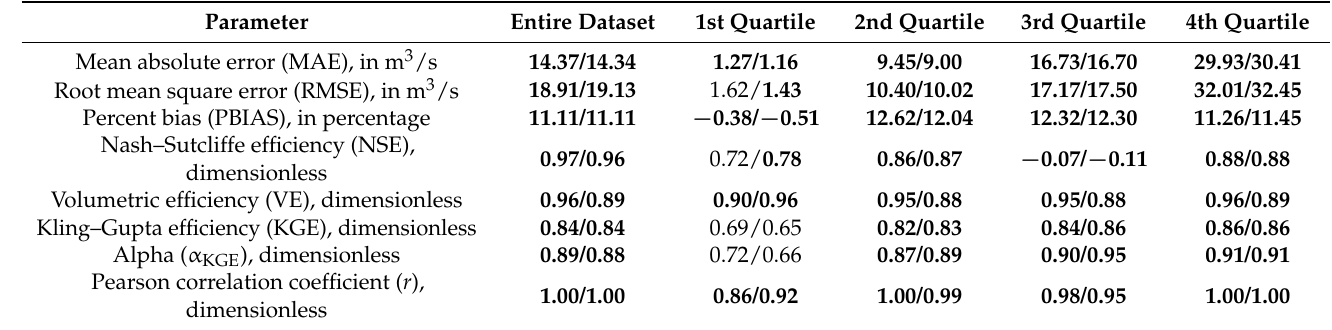
Table A2. Goodness-of-fit statistics associated with radar-based and USGS-streamgage-based dis- charge measurements, from the hybrid-radar-based, rapid- φ dataset. Values in bold indicate they meet this study’s criteria for satisfactory performance defined in Section